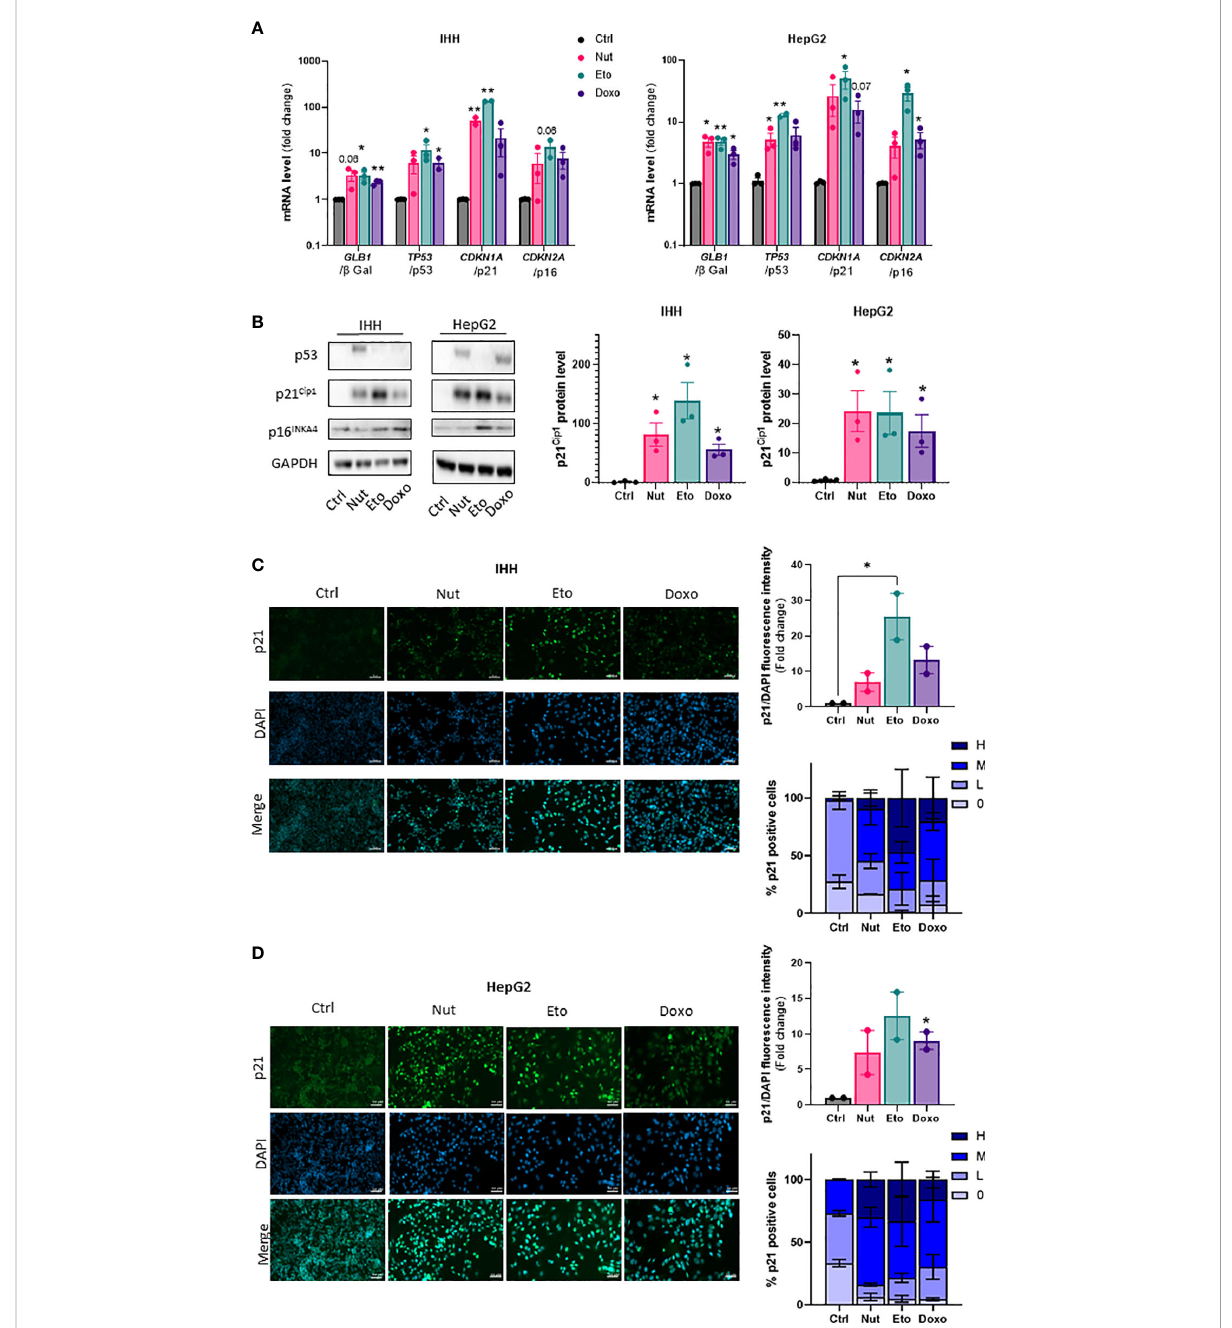
FIGURE 1 Nutlin-3a, etoposide and doxorubicin treatment increase senescence markers in human hepatocytes. IHH and HepG2 cells were treated with nutlin-3a (Nut; 3 µM), etoposide (Eto; 20 µM) and doxorubicin (Doxo; 0,2 µM) for 5 days. (A) mRNA expression of senescence markers normalized to GAPDH . (B) Western blot analysis of senescence markers p53, p21 Cip1 and p16 INK4a , and GAPDH as a loading control. Quanti fi cation of p21 protein levels were normalized GAPDH levels. (C) p21 immuno fl uorescence in IHH and (D) HepG2 cells. Hepatocytes were stained for p21 (green) and nuclei (DAPI, blue). Scale bars represents 50 µm. p21 fl uorescence intensity was quanti fi ed with Image J and normalized to DAPI staining. The percentage of p21 positive cells was determined based on the degree of p21 fl uorescence intensity from an average of 6 different images per group (H = high, M = medium, L = low, 0 = no p21 fl uorescent signal detected). Results are expressed as Mean ± SEM. *P < 0.05, **P < 0.01 indicates a signi fi cant difference compared to control